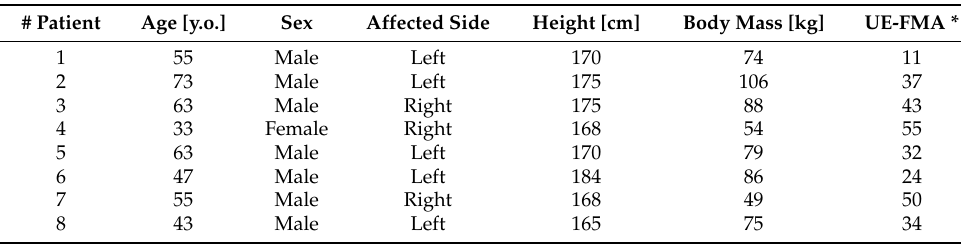
Figure 9. Example of the ε trends in time retrieved by SSE 2 during the execution of the CM task performed by a healthy volunteer ( a ) and a hemiplegic patient ( c ) in Round 1 and Round 2. Mean SD values calculated for the 7 SSEs (# SSE) during the three tasks performed by the healthy volunteers ( b ) and hemiplegic patients ( d ) in Round 1 and Round 2. Table 4. Features of the hemiplegic